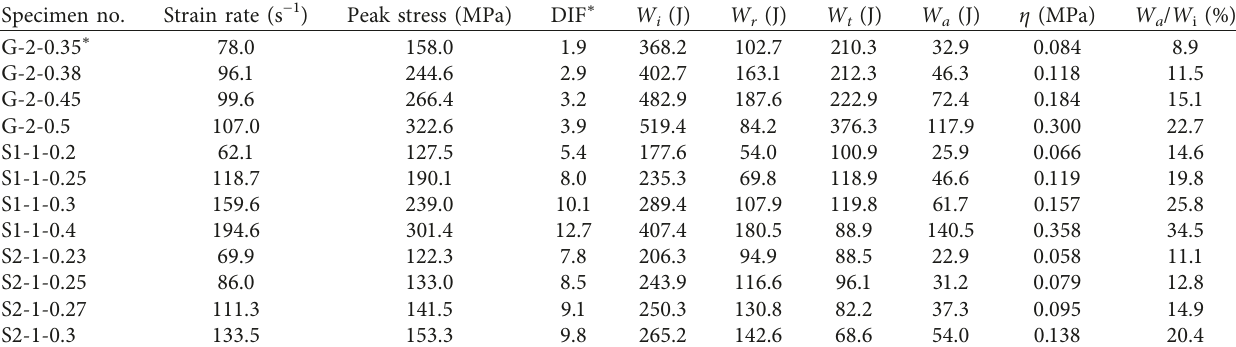
Table 2: Dynamic mechanical parameters of different specimens for SHPB test.